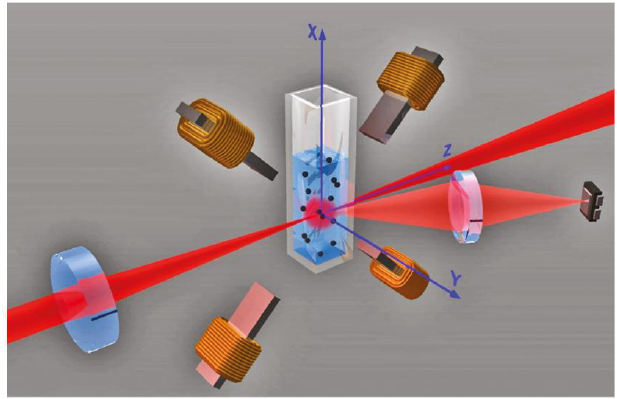
Figure 11. Sketch of the setup for analyte detection by scattering observation of the magnetorotation of magnetic particle label clusters. Reprinted with permission from [232]. Copyright 2011, American Chemical Society.